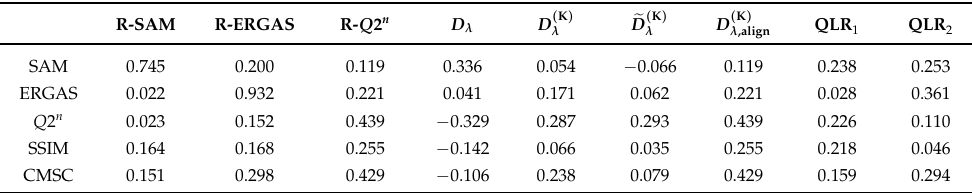
Table 4. Correlation coefficient among different indexes (some have been complemented for a uniform polarization) obtained on the misaligned RR WV2 datasets.